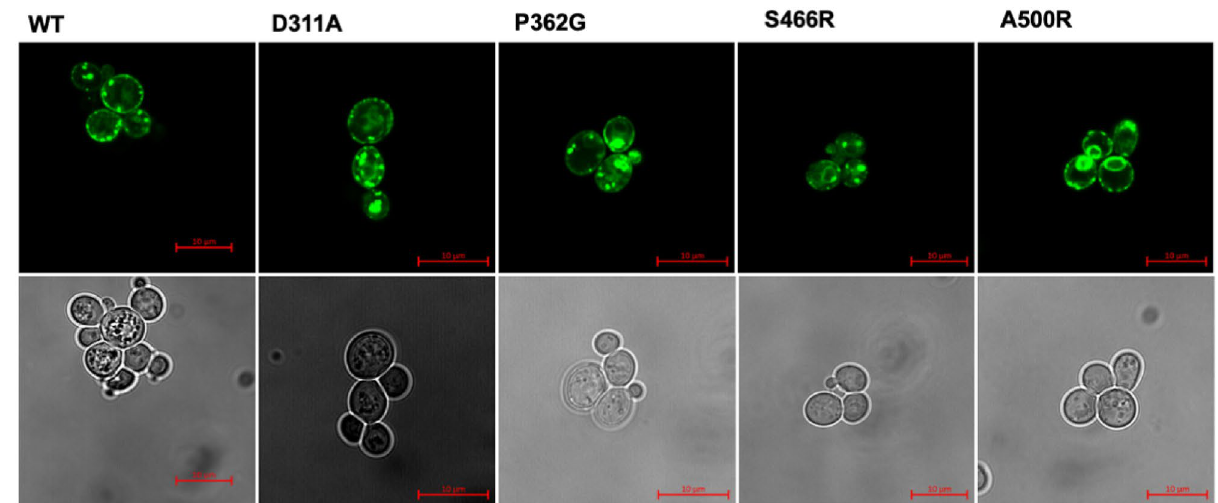
Figure 2. Localisation of AtBOR1-GFP variants in yeast strain FGY217. The proteins were visualised using both confocal fluorescence microscopy for detection of GFP (upper panel) and corresponding bright field images (lower panel). Data shown is representative of at least n = 2 independent experiments. Scale bar = 10 μm.